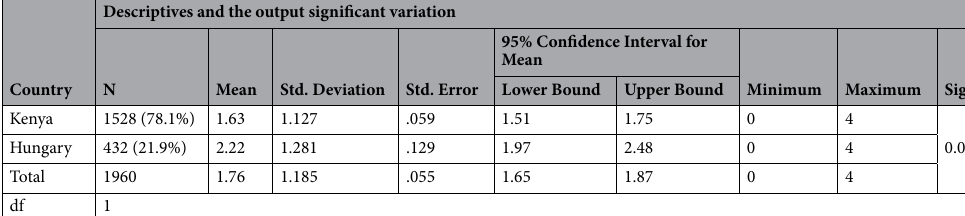
Table 2. The table shows a statistical output on variation in information/knowledge acquired on the efficacy of the developed vaccines against the SARS-CoV-2 virus.